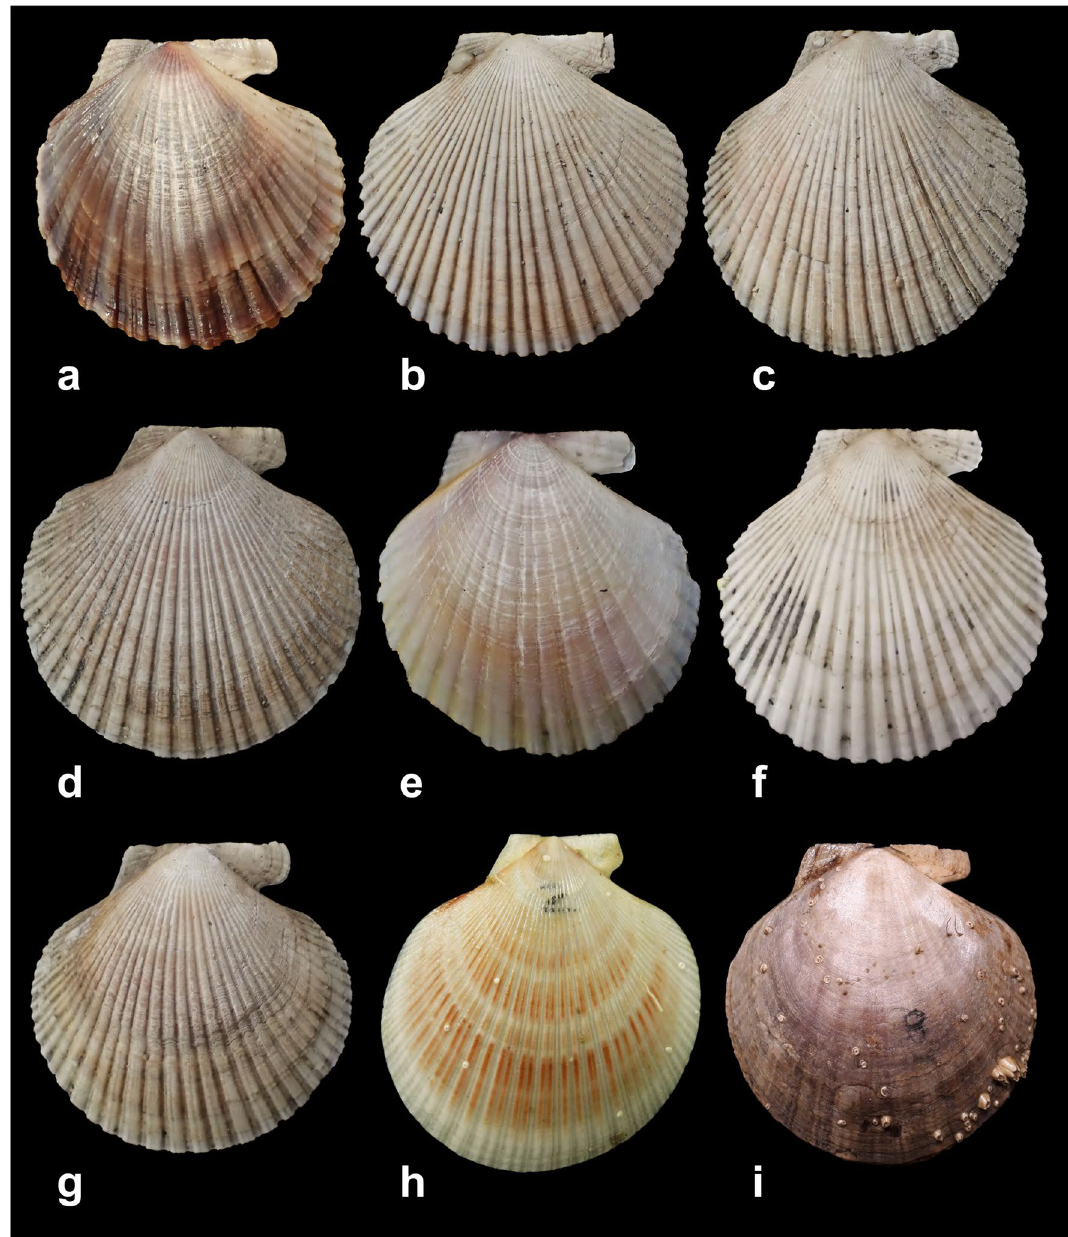
Figure 2. Photographs of Magallanes scallops. ( a ) and ( e ) Austrochlamys natans from Pia Sound ( b – d) , ( f) , ( g ) Zygochlamys patagonica (Pia Fjord), ( h ) Z. patagonica (Diego Ramirez Archipielago), and ( i ) A. natans (Montaña Fjord)